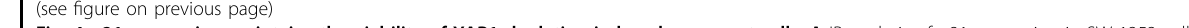
Fig. 4 p21 expression maintains the viability of YAP1 depletion-induced senescent cells. A IB analysis of p21 expression in SW 1353 cells treated with DMSO or different concentrations of Vertepor fi n (0.01, 0.1, 1, and 10 μ M) for 24 h. B The percentage of SA- β -gal-positive cells in the above treatments was quanti fi ed. C IB analysis of p21, c-Myc, and PARP expression in SW 1353 cells treated with DMSO or different concentrations of Vertepor fi n (0.1, 1 μ M) for 24 h. D Flow cytometry analysis of cell apoptosis in the presence or absence of Vertepor fi n treatments. E , F Knockdown of p21 abolishes YAP depletion-induced senescence. Control shRNA or YAP1-depleted SW 1353 cells were transfected with p21-speci fi c siRNAs (siControl, sip21#3 and sip21#4) for 72 h followed by SA- β -gal staining ( E ), and SA- β -gal-positive cells were quanti fi ed ( F ), scale bars: 20 μ m. G , H p21 knockdown enhances YAP depletion-induced DNA damage. SW 1353 cells stably expressing control shRNA or shYAP1#4 were transfected with p21- speci fi c siRNAs (siControl or sip21#4), and DNA damage was detected by a comet assay ( g ) and analyzed by the OTM ( H ), scale bars: 20 μ m. I γ -H2AX foci were calculated in shYAP1#4 cells with/without p21 depletion. J Knockdown of p21 increases YAP1-depleted cell apoptosis. The expression of the indicated proteins was determined by IB. K SC and shYAP1#4 stable SW 1353 cells were subcutaneously inoculating into the nude mice at the right fl ank next to the forelimb, then the mice 37 days post inoculation (de fi ned with light blue arrow) were treated with p21 inhibitor (I-p21, UC2288) for four times within 7 days, then tumor growth curves were constructed based on the tumor volumes measured every 3 days. L Frozen sections of fresh xenograft tumor were stained with SA- β -gal and the percentage of SA- β -gal-positive cells was determined. M , N Tumor sections of were stained with TUNEL (m, DAPI for nuclear staining) and the TUNEL-stained cells were quanti fi ed ( N ). O An illustration reveals that targeting p21 in YAP1-depleted cells switches cellular senescence to apoptosis. Data are presented as the mean ± SD of at least three independent experiments in ( B , D , F , H , I , K , L , N ). One-way ANOVA followed by Dunnett ’ s test was applied for ( B , D , I ). Student ’ s t -test for ( I ). Two-way ANOVA followed by Tukey ’ s test for ( F , K , L , N ). Mann – Whitney U test for ( H ). n.s. nonsigni fi cant, ** P < 0.01, *** P < 0.001, **** P <